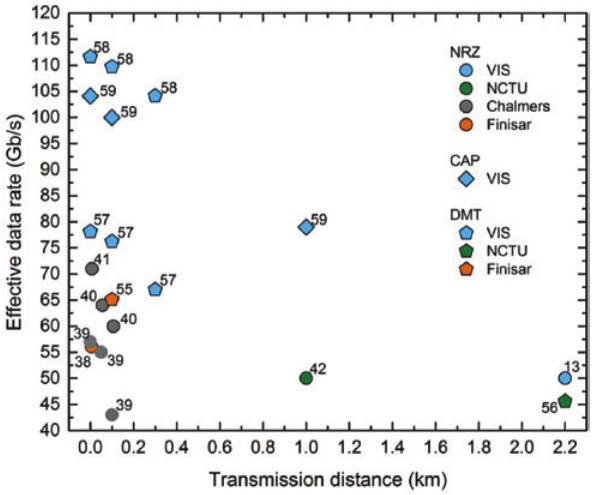
Figure 14: Effective data rate vs. MMF transmission distance for NRZ, DMT, and